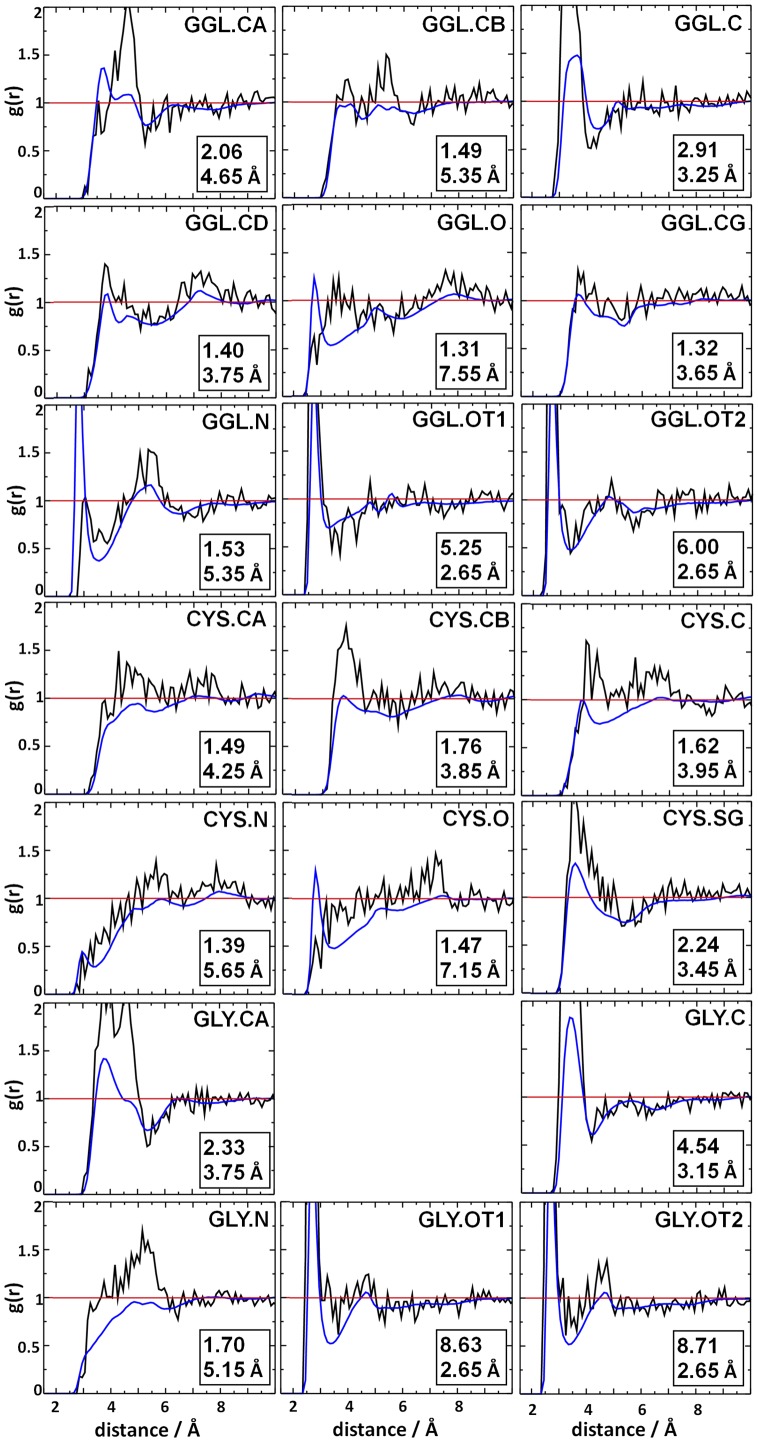
The radial distribution functions (g(r)) were calculated between the oxygen atom of water (blue curves) or OH• (black curves) and all heavy atoms in GSH for the GSH/OH• system.The maximum g(r) values and the corresponding distance for OH• are indicated in the lower right corner of each graph.